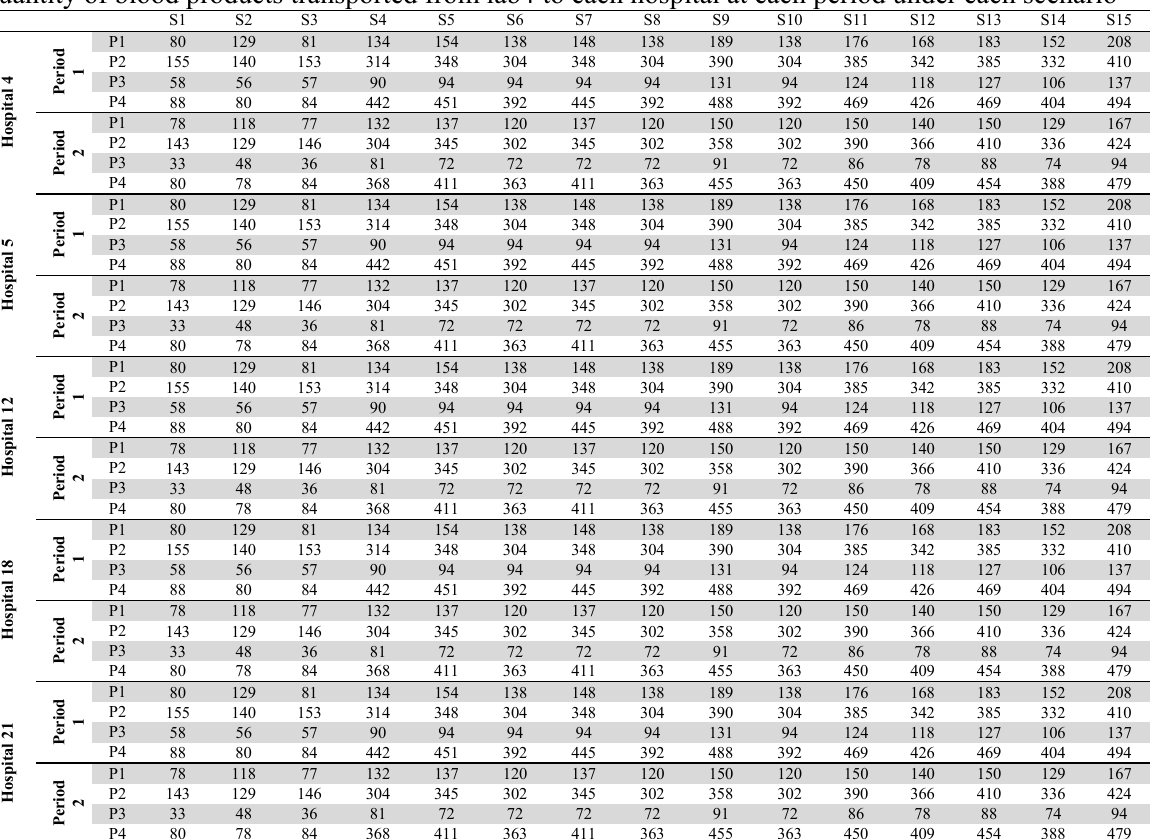
Quantity of blood products transported from lab4 to each hospital at each period under each